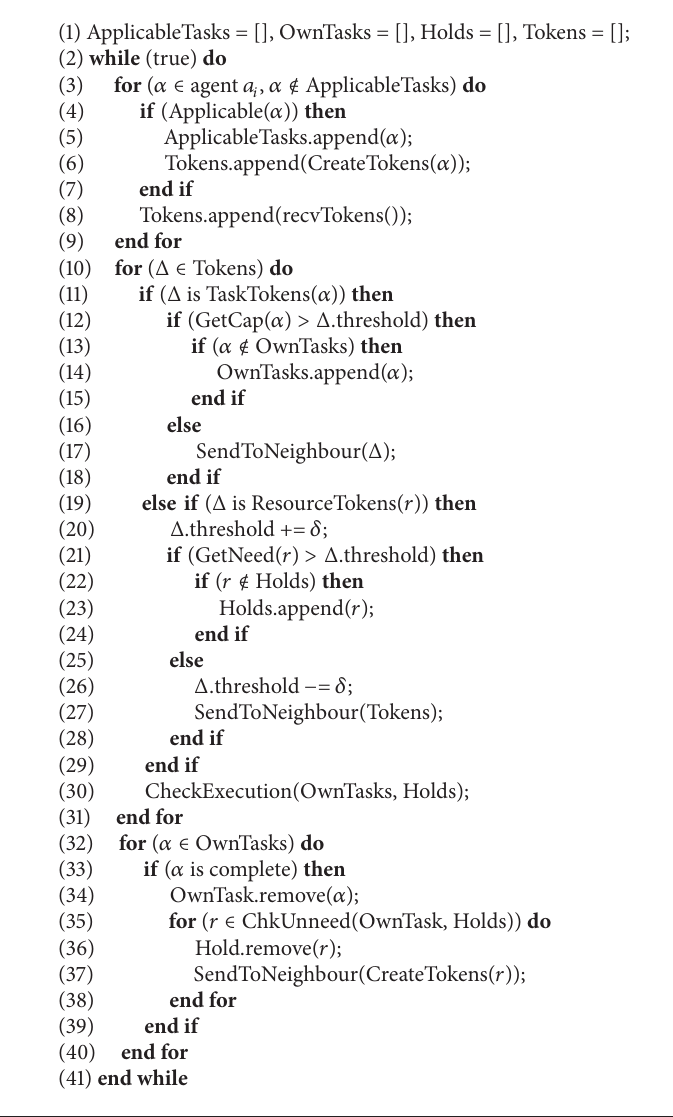
Algorithm 1: General process of agents’ communication